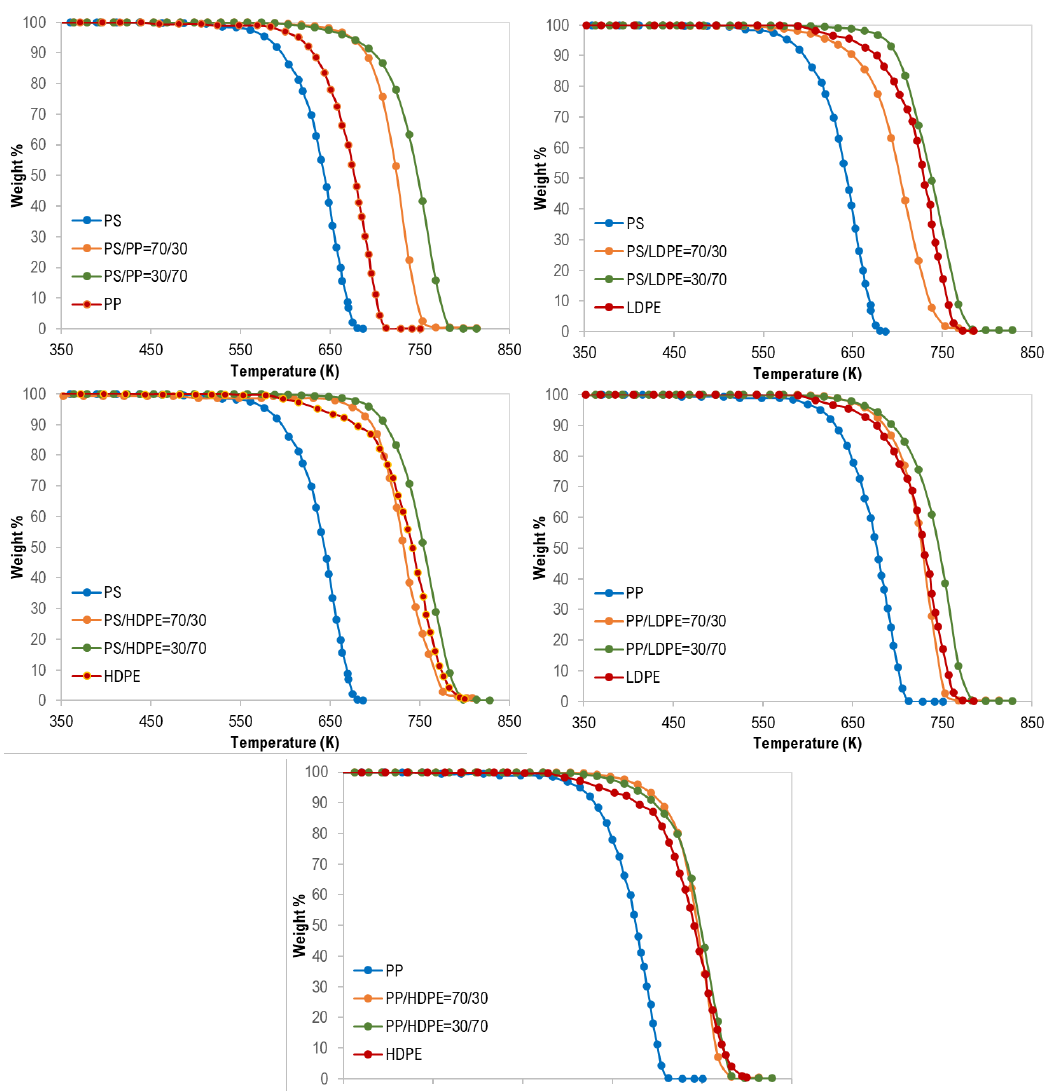
Figure 3. Synergistic effect on the co-pyrolysis of polymer samples.